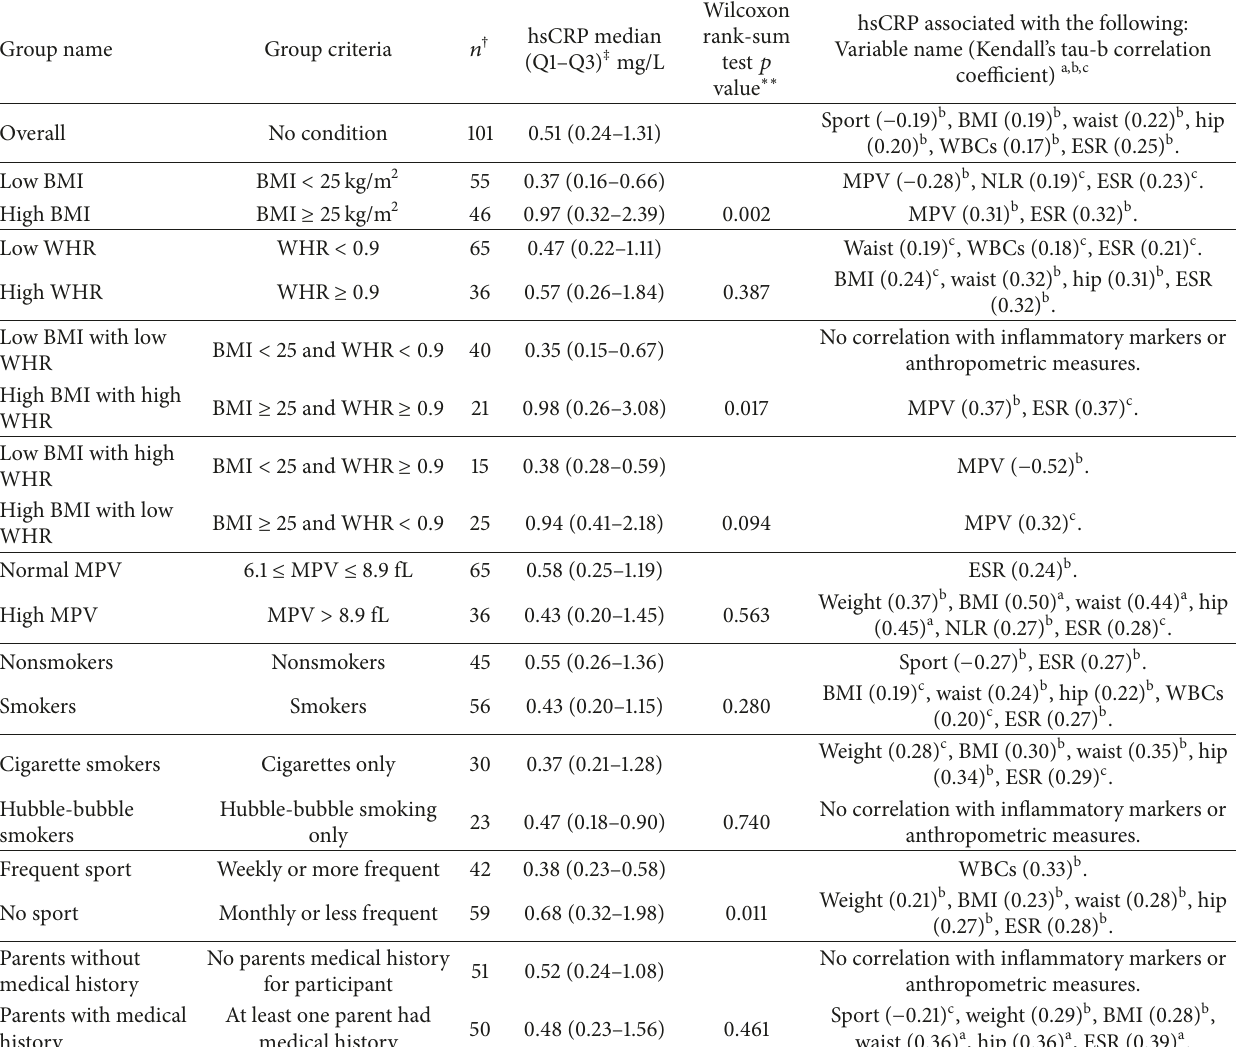
Table 7: Using appropriate inclusion criteria, the participants were divided into two opposite groups. To check the difference significance of hsCRP levels (mg/L) between them, Wilcoxon rank sum test was applied. To reveal the possible associations, Kendall’s tau-b correlation coefficients between hsCRP and other variables were used ∗